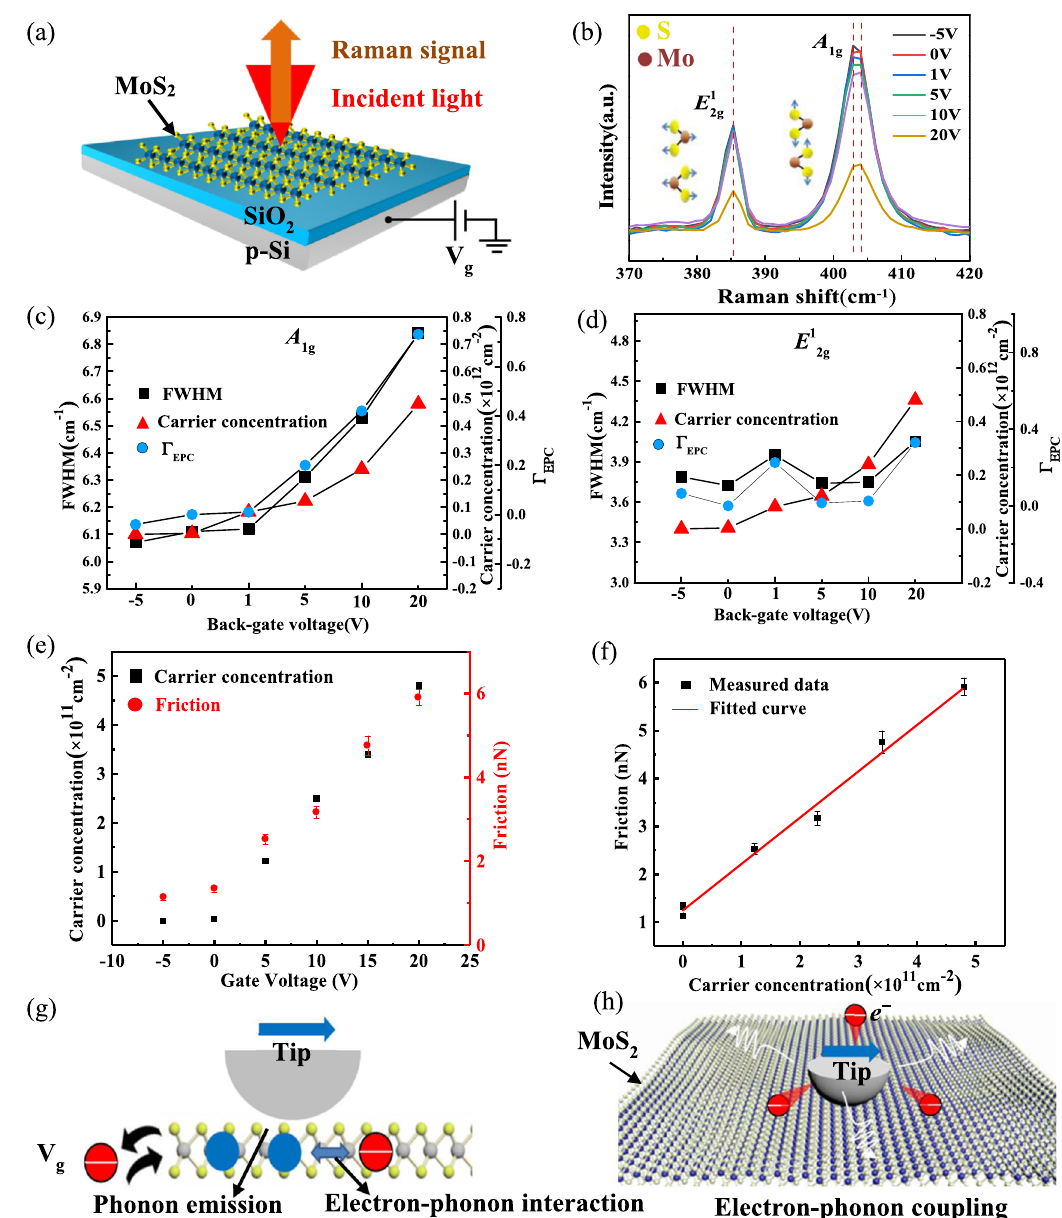
Fig. 6 The in fl uence of normal electric fi eld on nanofriction using Raman spectroscopy. a Raman experimental setup. b Raman spectra of atomically thin MoS 2 under different V g . c FWHM and carrier concentration of A 1g mode as a function of V g . d FWHM and carrier concentration of E 1 2g mode as a function of V g . e Carrier concentration and friction as a function of gate voltage. f Plots of the friction as a function of carrier concentration. g AFM tip sliding on atomically thin MoS 2 emitting electron and phonon pairs. h Schematic diagram of the energy dissipation as the AFM tip slides on atomically thin MoS 2 . Error bars represent standard